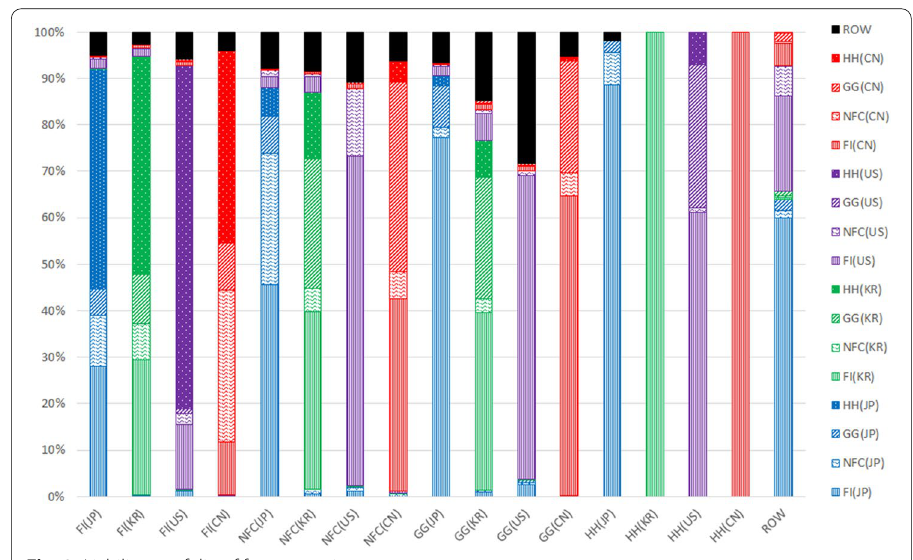
Fig. 3 Liability portfolio of four countries